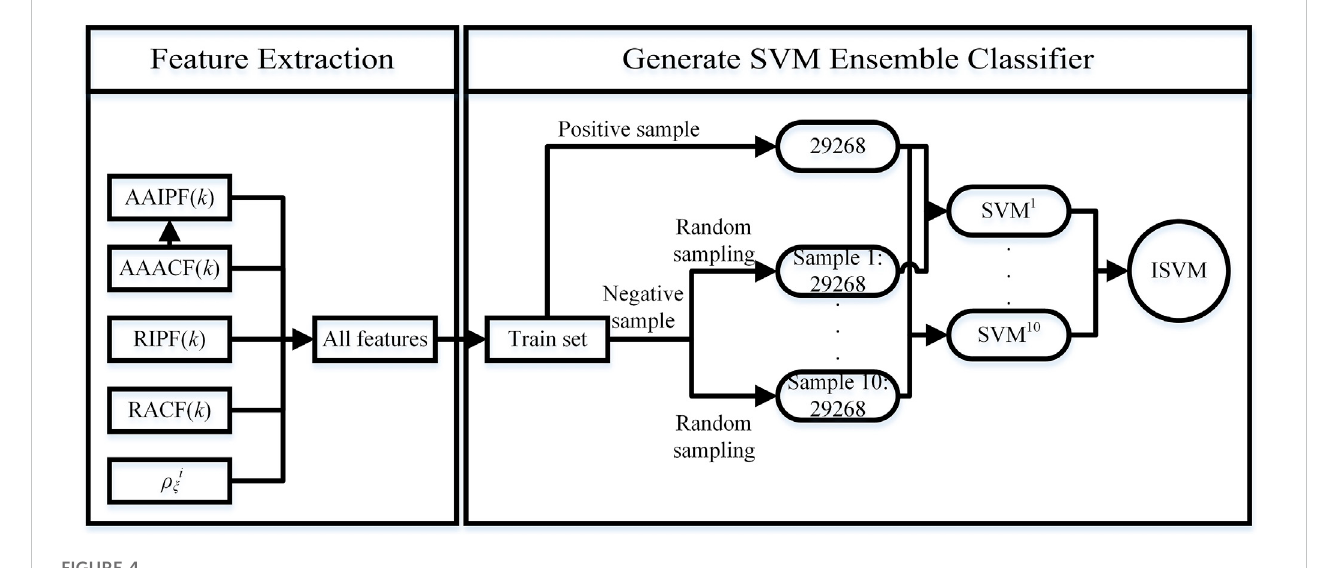
FIGURE 4 Flow chart of the SVM Ensemble Method.